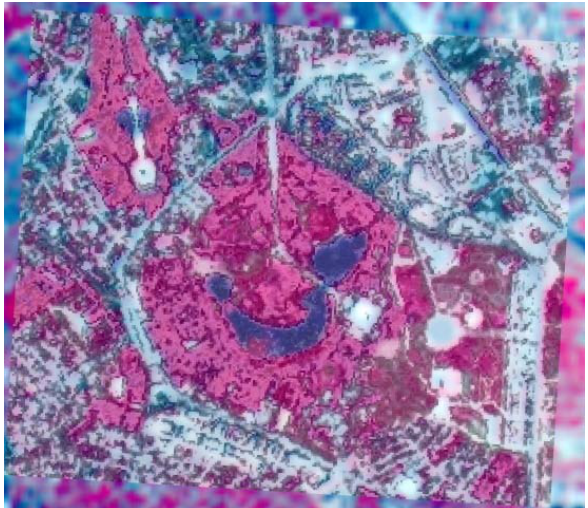
Figure 9. SPOT HRV pansharpened image of study area Based on the fact that intensity I (digital number, DN, of each pixel) depends mostly on external factors, such as sun angles, surface orientation, shadow, a band normalization was used which splits the intensity and reflectance to allow proper feature extraction. This was carried out by dividing the DN value of the panchromatic band by the DNs sum of the three multispectral bands for each image pixel (resampled to 10 m scene pixel). Ip/Id × scaling factor, where Ip is the DN of panchromatic image pixel and Id is R+G+B= sum norm. First, for all image pixels the three bands (R, G, B) sum which represents the total intensity was calculated and the result was merged with the enhanced panchromatic image to get the ratio. The final step was to merge the ratio result and the enhanced multispectral